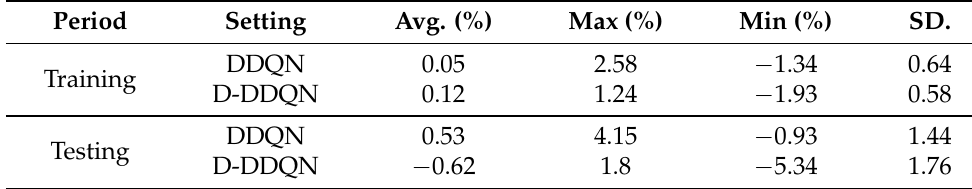
Figure 7. Average returns from DRL approach with Sharpe reward function. ( a ) Training period; ( b ) Testing period. Table 4. Average return performance with Sharpe reward function.